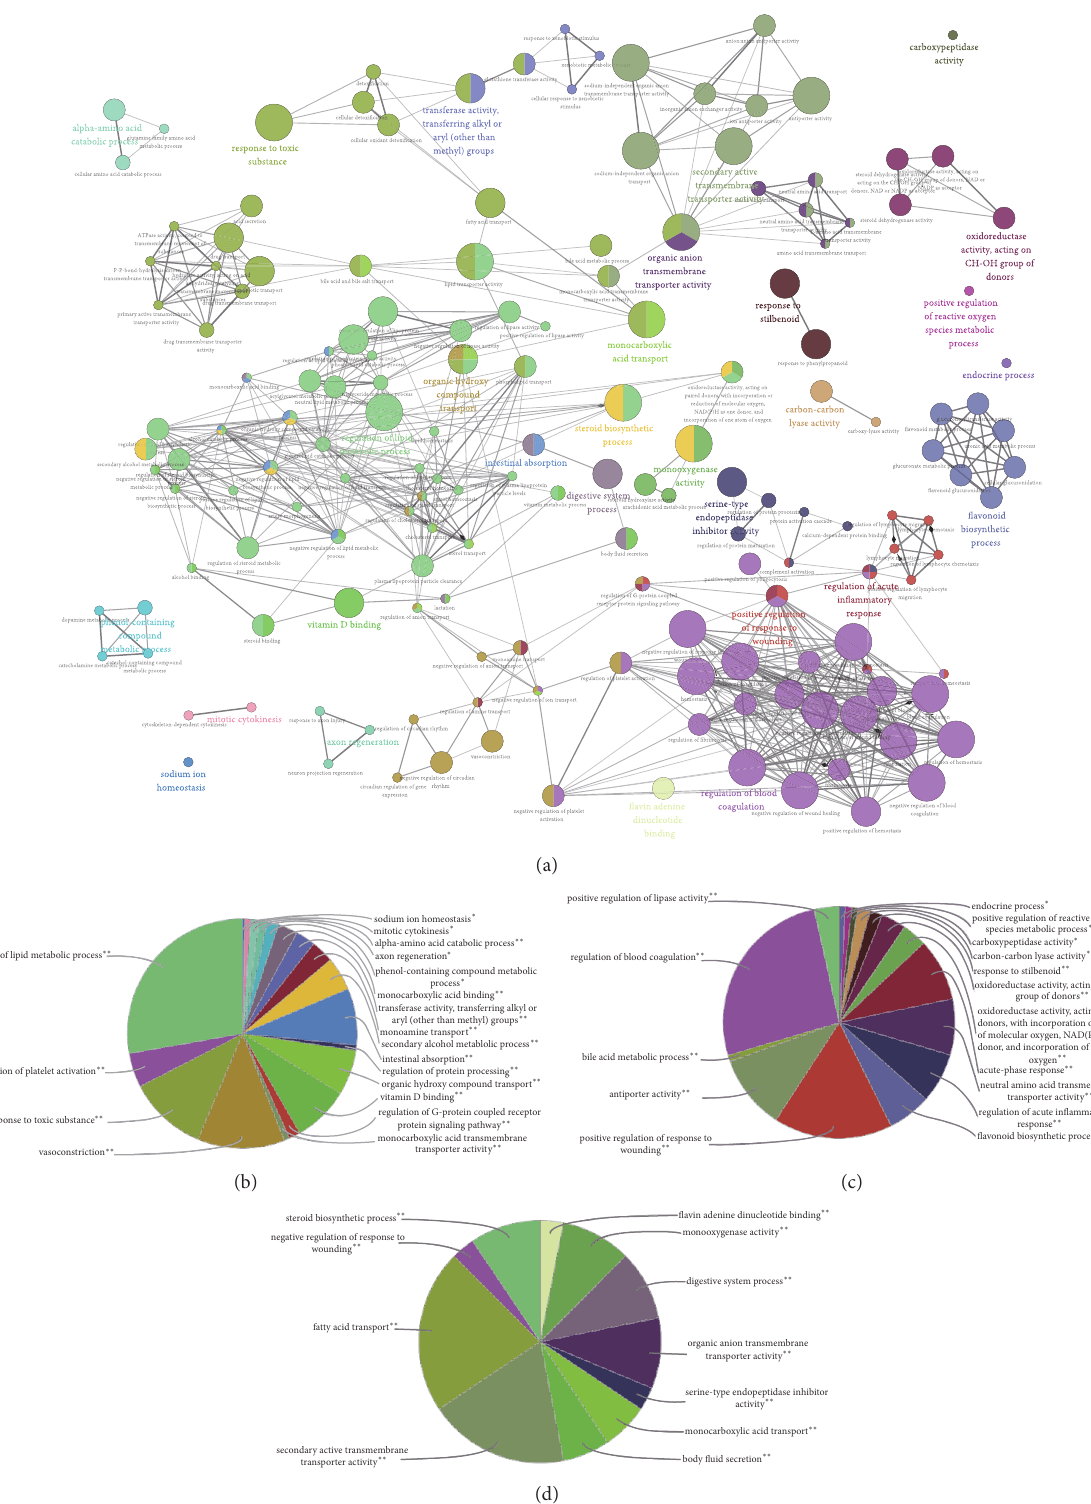
Figure 3: Functionally grouped network of enriched GO categories generated for the upregulated and downregulated genes. GO terms are represented as nodes. Functionally related groups partially overlap (a). Node pie charts represent the biological process analysis for upregulated genes (b) and downregulated genes (c) and uncertain genes